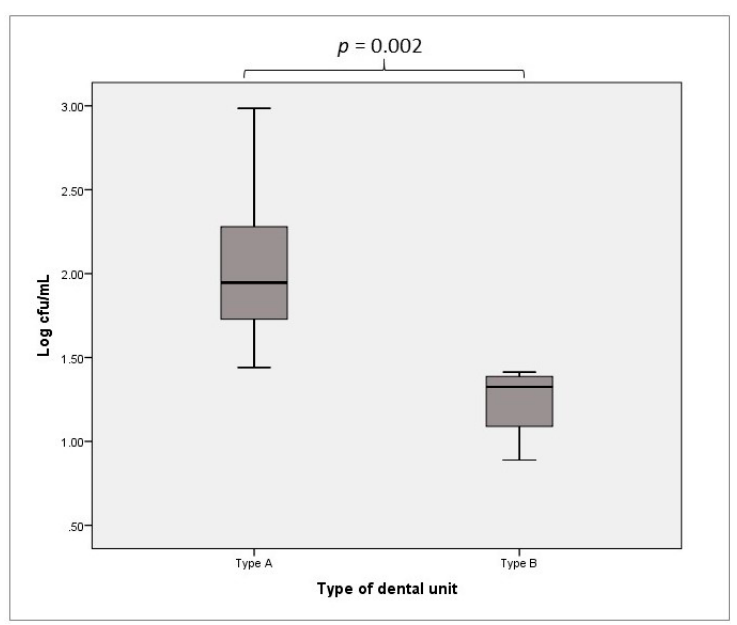
Figure 1. Heterotrophic plate counts (HPCs) at 36 °C: contamination of Type A vs. Type B DUWLs. In accordance with the standards prescribed for drinking water, P. aeruginosa must be absent (0 cfu/100 mL) from DUWLs [30,31,36]. In line with previous results, we found a difference in terms of positive samples between Type A and Type B DUWLs. In particular, 65/84 (77.4%) Type A DUWL samples and 4/16 (25.0%) Type B DUWL samples showed positive results. The HPCs at 36 ◦ C of the samples from Type A DUWLs ranged from 0.92 to 2.58 Log cfu/100 mL, with a median of 1.86 Log cfu/100 mL and an IQR of 0.73 Log cfu/100 mL. In contrast, the Type B DUWLs showed HPCs at 36 ◦ C in the range of 0.00 to 1.17 Log cfu/100 mL, with a median of 0.31 Log cfu/100 mL and an IQR of 1.04 Log cfu/100 mL. The differences between the two types of DUWLs were statistically significant ( p = 0.004, Figure 2).